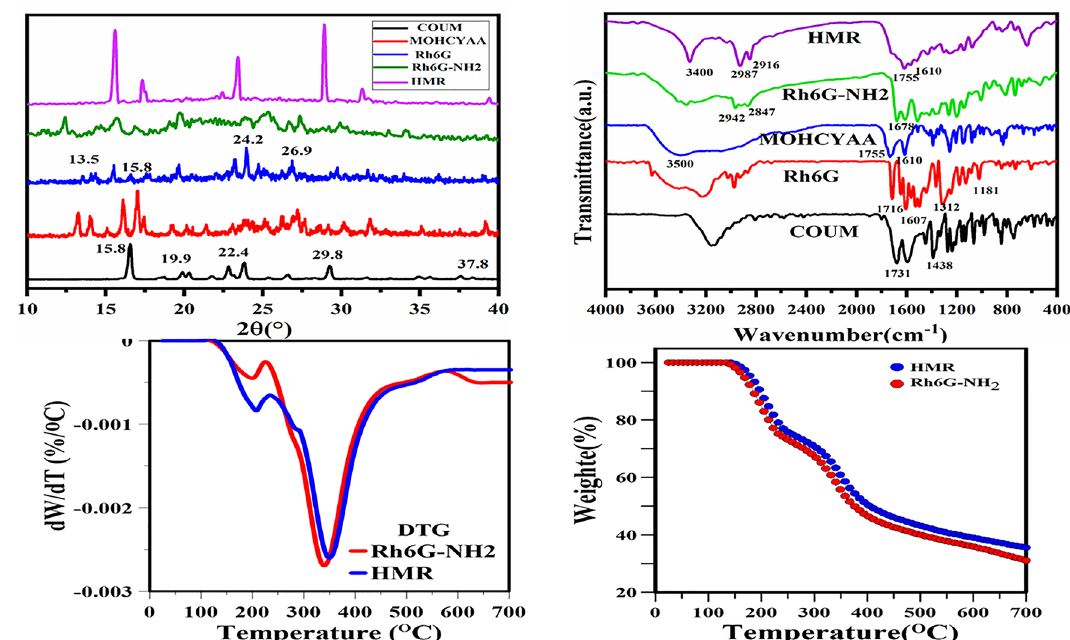
Figure 1. FTIR spectra, XRD patterns, TGA, and DTG thermograms of different samples.